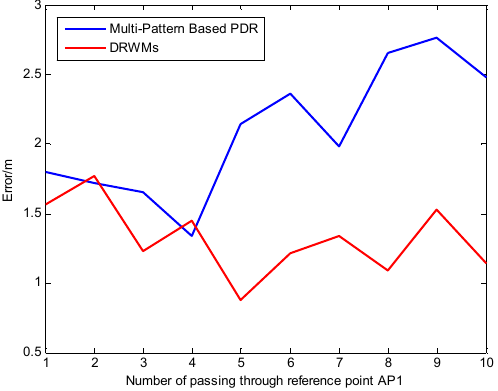
Figure 12. Comparison of error with long-term estimation.